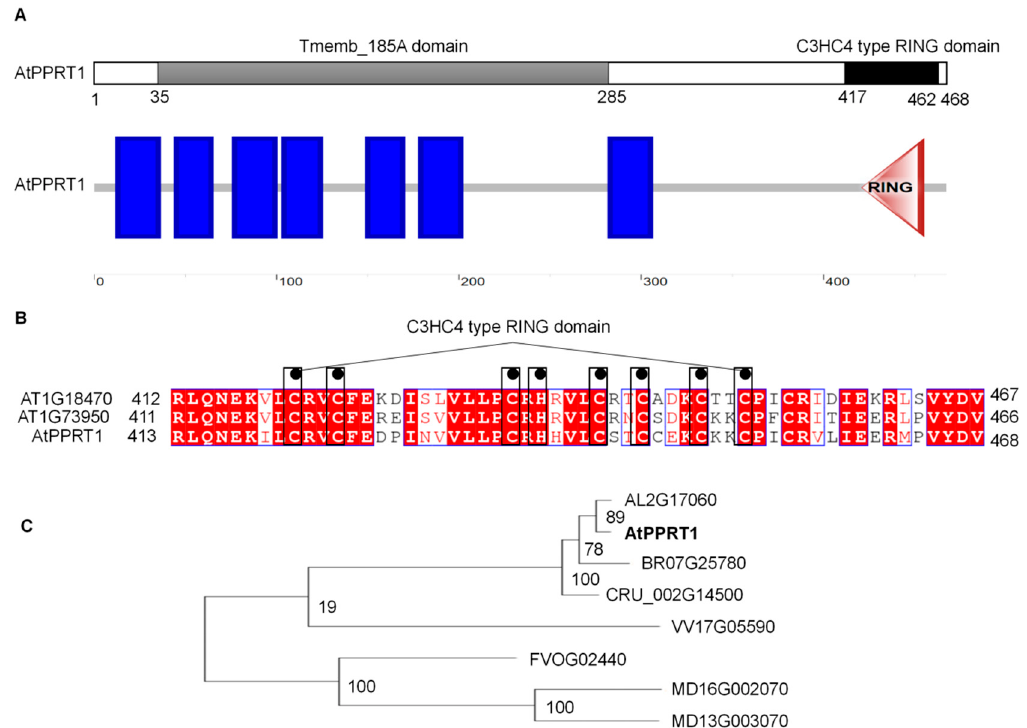
Figure 1. Domain organization and phylogenetic analysis of AtPPRT1. ( A ) Schematic diagram of AtPPRT1. The gray and dark bars in the upper line indicate the Tmemb_185A and RING (Really Interesting New Gene) domains. The blue boxes and red triangle in the lower line indicate the transmembrane and RING domains, respectively; ( B ) The RING domains of three Arabidopsis AtPPRTs. The amino acids of the RING domain were aligned using DNAMAN8.0; ( C ) Phylogenetic relationship of PPRTs and its homologs. Eight PPRT proteins from seven species were selected and analyzed by MEGA7.0. Bootstrap values from 1000 replicates are indicated at each node.